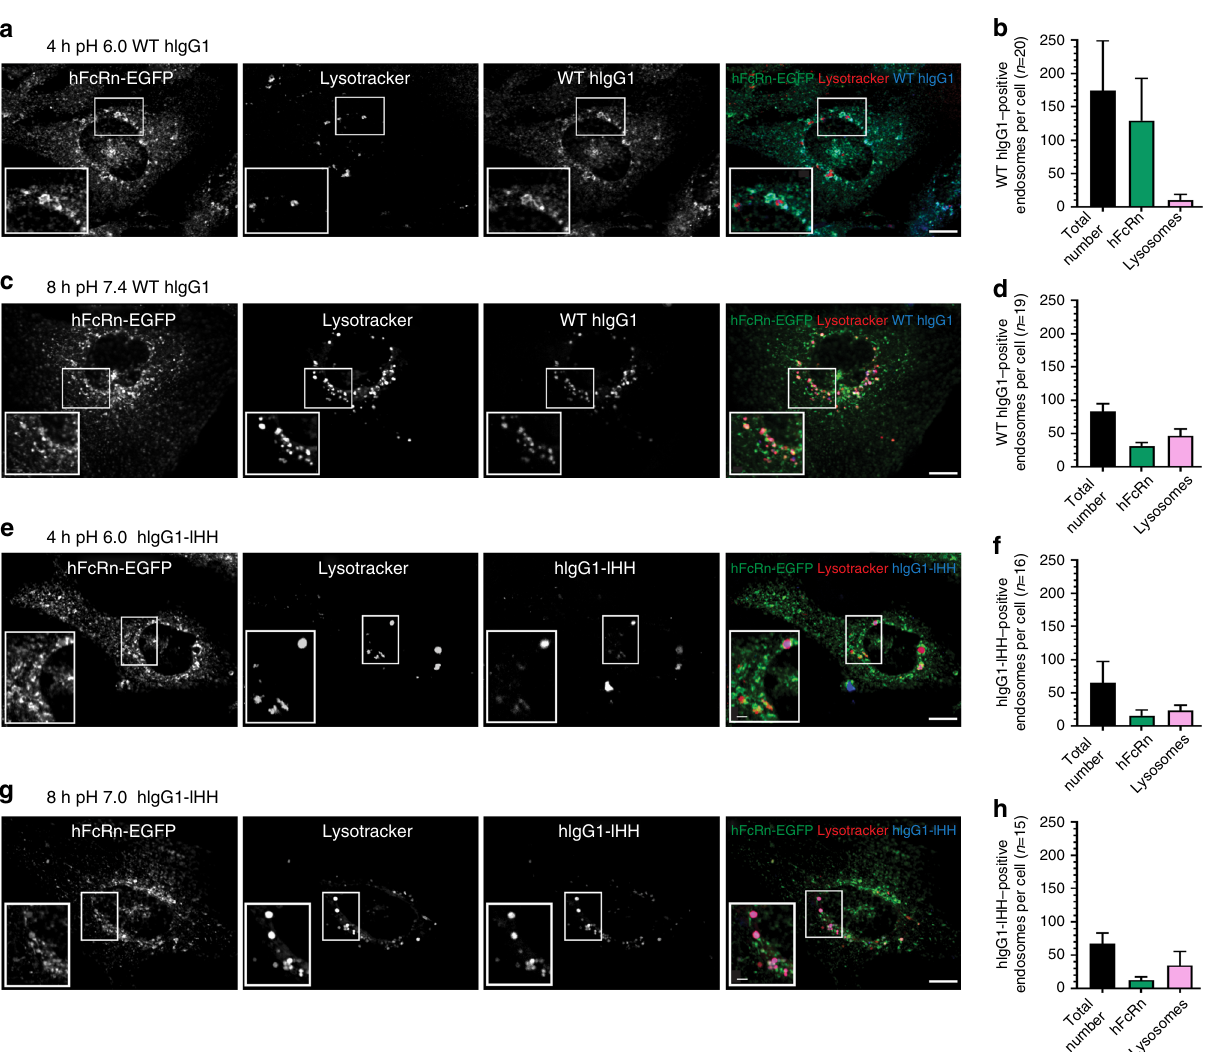
Fig. 3 Visualization of FcRn-mediated transport of IgG in HMEC1-hFcRn cells. HMEC1-hFcRn cells were seeded in eight-well Nunc TM Lab-Tek TM chambered Coverglass imaging dishes, and live cell imaging was performed the day after. a Cells were washed three times with HBSS pH 6.0 and incubated with 400 nM Alexa-labelled WT hIgG1 diluted in HBSS pH 6.0 for 4 h at 37 °C. Cells were incubated with Lysotracker DND-99 for 30 min before washed with HBSS pH 6.0 and images were taken. b WT hIgG1 co-localization with FcRn-positive endosomes or lysosomes after 4 h incubation ( n = 20 cells). c The same cells as in a were washed three times with HBSS pH 7.4 followed by additional 4 h incubation at 37 °C before images were taken. d WT hIgG1 co- localization with FcRn-positive endosomes or lysosomes after additional 4 h incubation ( n = 19 cells). e Cells were washed three times with HBSS pH 6.0 and incubated with 400 nM Alexa-labelled hIgG1-IHH diluted in HBSS pH 6.0 for 4 h at 37 °C. Cells were incubated with Lysotracker DND-99 for 30 min and washed with HBSS pH 6.0 before images were taken. f hIgG1-IHH co-localization with FcRn-positive endosomes or lysosomes after 4 h incubation ( n = 16 cells). g The same cells as in e were washed three times with HBSS pH 7.4 followed by additional 4 h incubation at 37 °C before images were taken. h hIgG1-IHH co-localization with FcRn-positive endosomes or lysosomes after additional 4 h incubation ( n = 15 cells). Representative confocal images at each condition are shown. Large scale bar — 10 µ m; small scale bar — 2 µ m. Co-localization analyses were performed using Imaris spot co-localization. Data are shown as mean ± s.d. from two independent experiments were n = 20 ( b ), 19 ( d ), 16 ( f ) and 15 ( g )